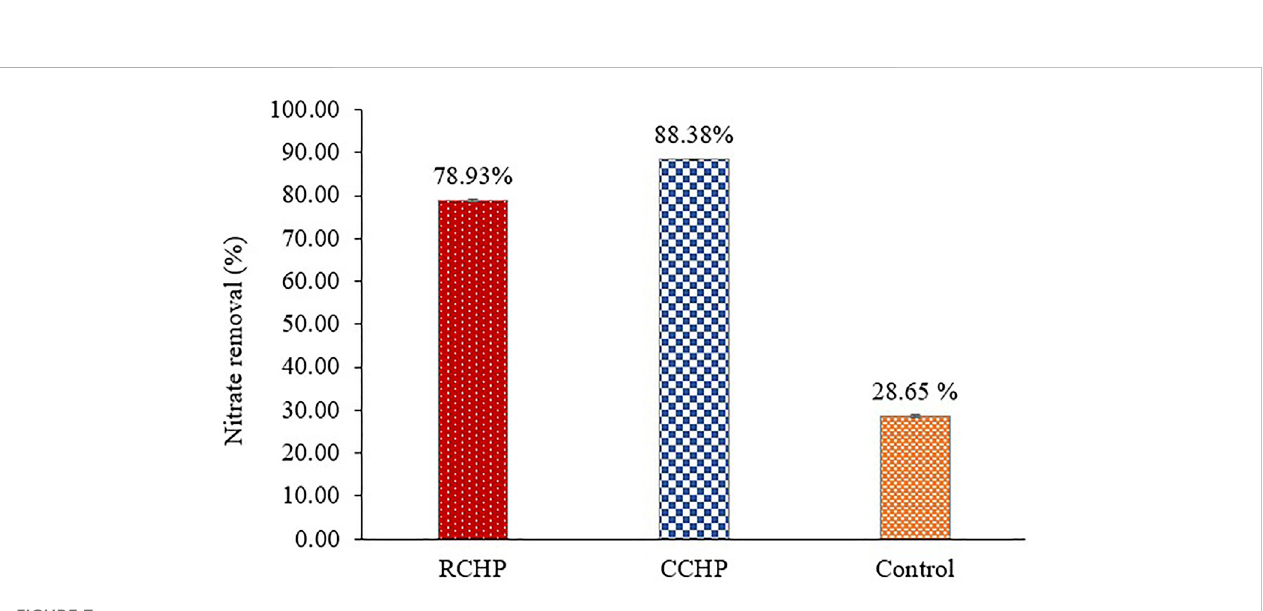
FIGURE 7 Effect of pyrolysis on nitrate